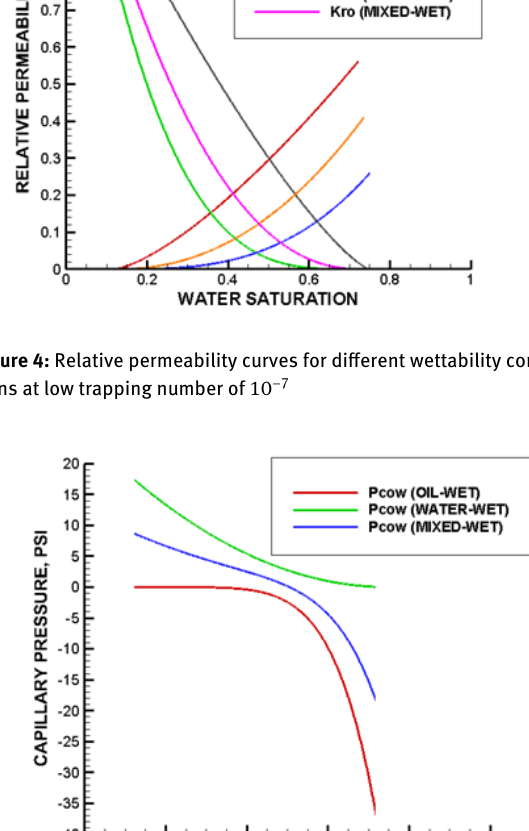
round the core. The middle 5×5×5 portion of the grids was given petrophysical properties representing the rock (Ta- ble 3) and the remaining gridblocks were given properties representing the imbibition cell.